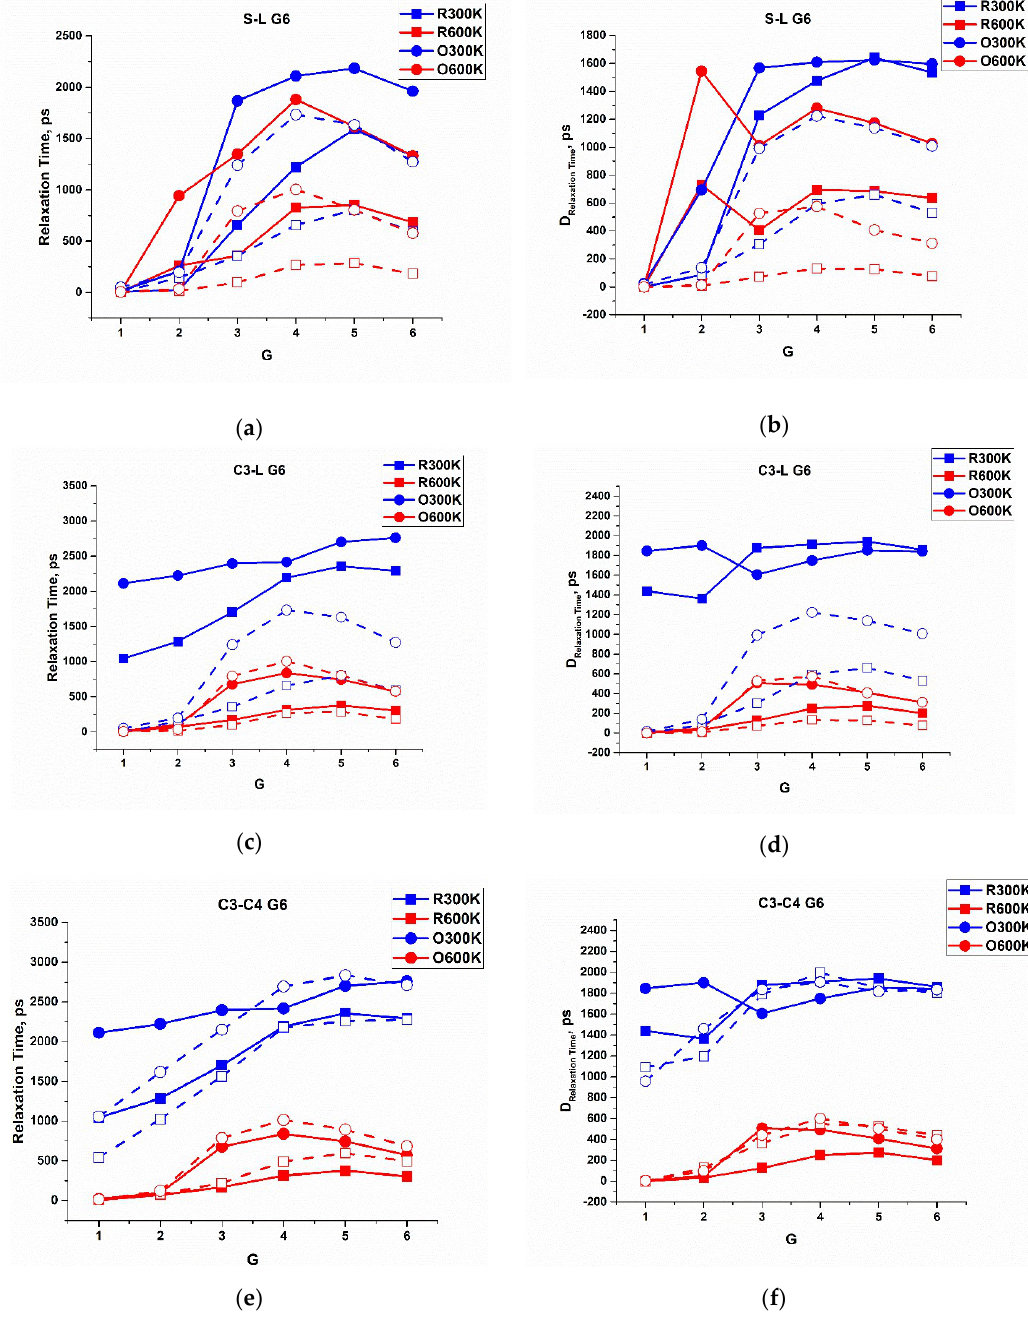
Figure 9. Dependences of the mean relaxation times (left column) and their variations (right column) for the radial (blue) and angular (red) motion of Si branching atoms on the branching layer number for the six generation of s- (solid line) and l-dendrimers (dashed line) ( a , b ); l- (solid line) and c3-dendrimers (dashed line) ( c , d ); and c3- (solid line) and c4-dendrimers (dashed line) ( e , f ), at 300 and 600 K.